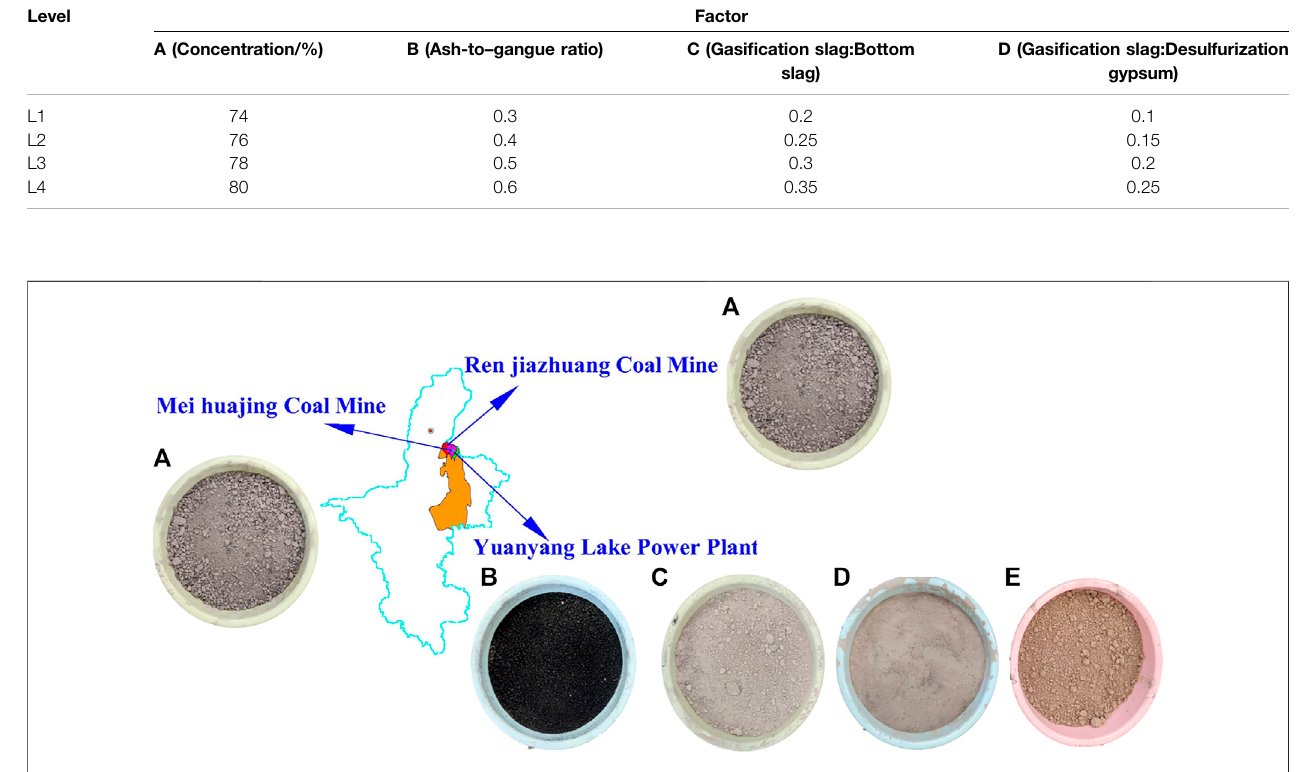
FIGURE 2 | Coal based solid waste materials: (A) coal gangue, (B) fl y ash, (C) gasi fi cation slag, (D) furnace bottom slag, and (E) desulfurization gypsum.